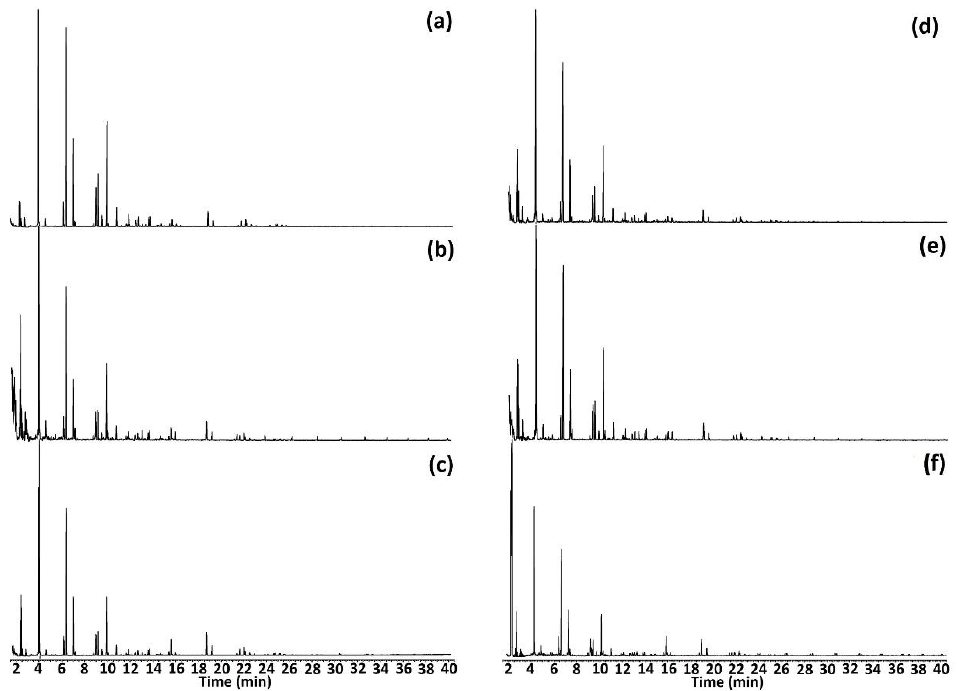
Figure 6. GC-MS chromatograms of U-tube condenser liquid products of catalytic pyrolysis of BMP